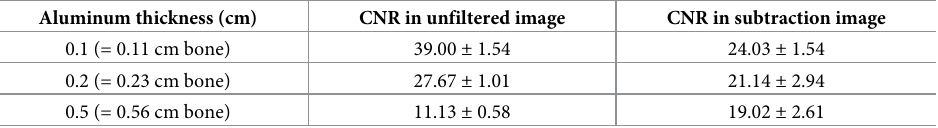
Table 1. CNR values calculated between iodine and aluminum for different thicknesses of aluminum. It can be seen that starting from a certain background absorber level, the CNR in the KES image is increased. The equivalent bone thicknesses were calculated with data adapted from the XMuDat software